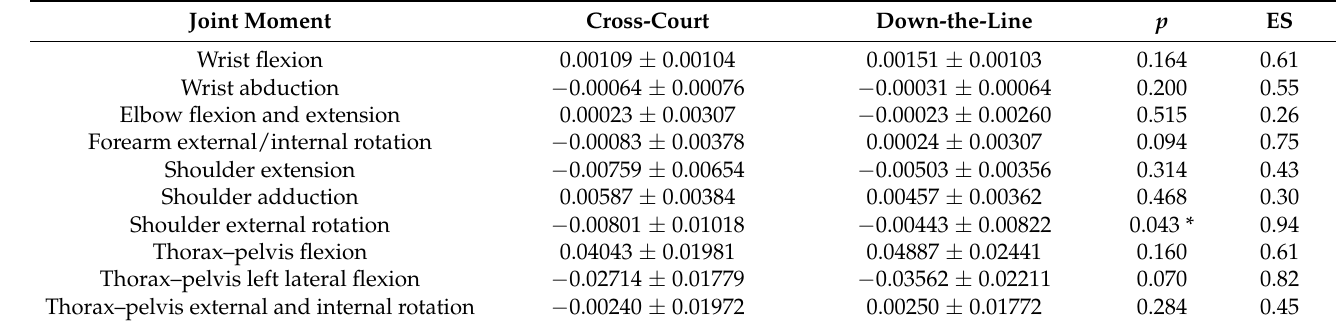
Table 6. The joint moment of upper body at the impact ( n = 8).